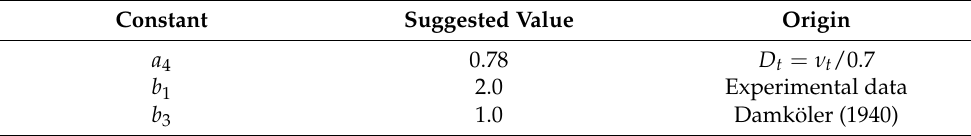
Table 1. Constants used for the correlation of the equilibrium wrinkling factor. Constant Suggested Value